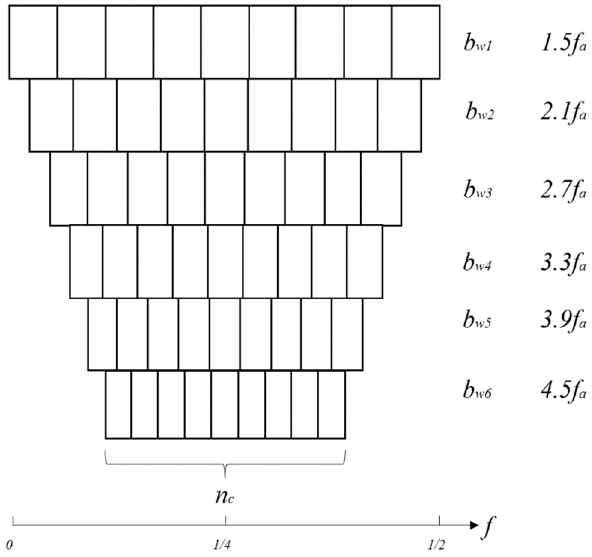
Figure 2. Schematic diagram of the filter ‐ bank analysis.